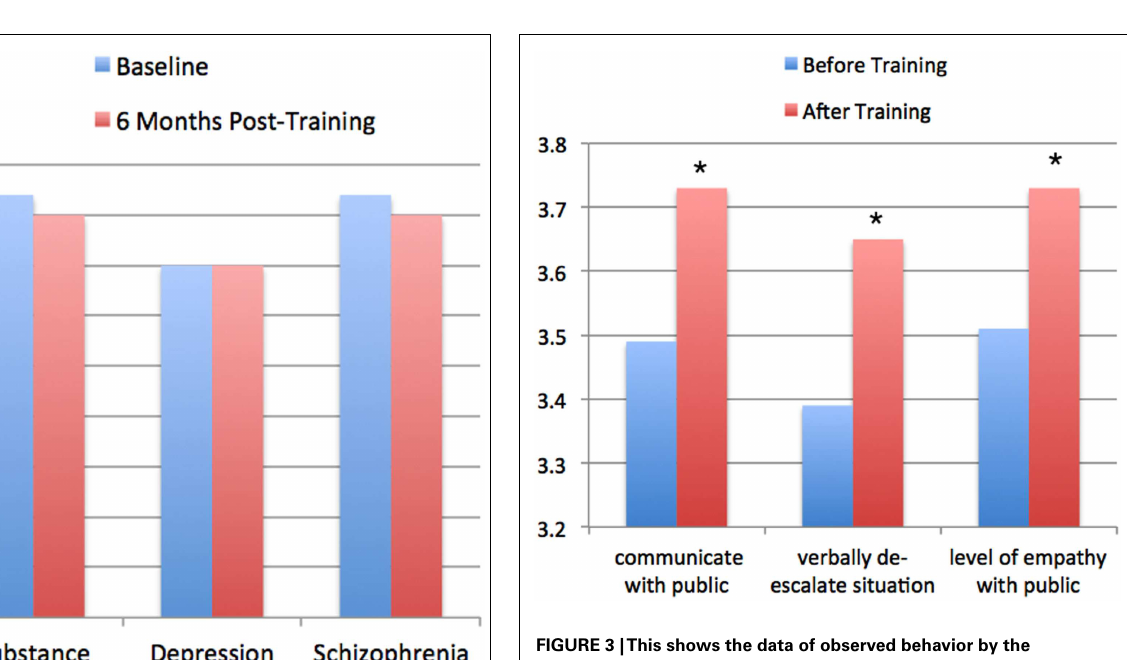
the sample for measured changes in behavior. Comparing these